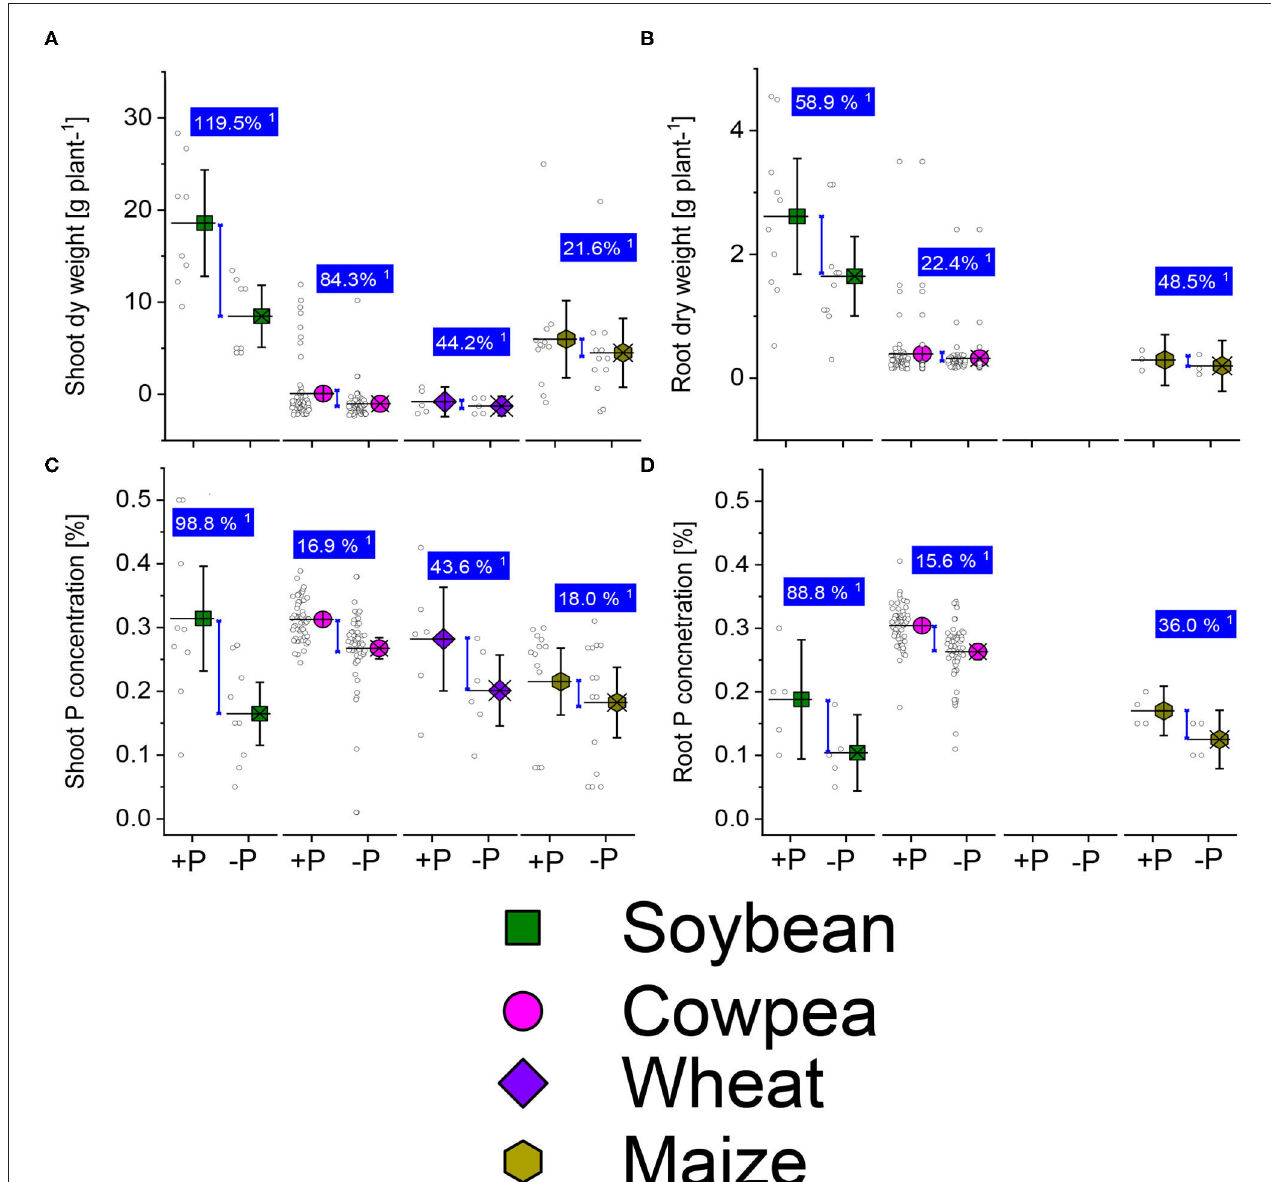
FIGURE 4 | Boxplots and scatter data of shoot (A) root (B) dry weights, shoot-P (C) and root-P (D) internal concentrations under + P and − P under drought or water deficit conditions of soybean, cowpea, wheat, and maize plants. 1 Average change (%) of the + P applied over P-deficient plants. Means + bootstrap at 95% CIs of two tested P treatments that do not overlap indicate a significant relative increase